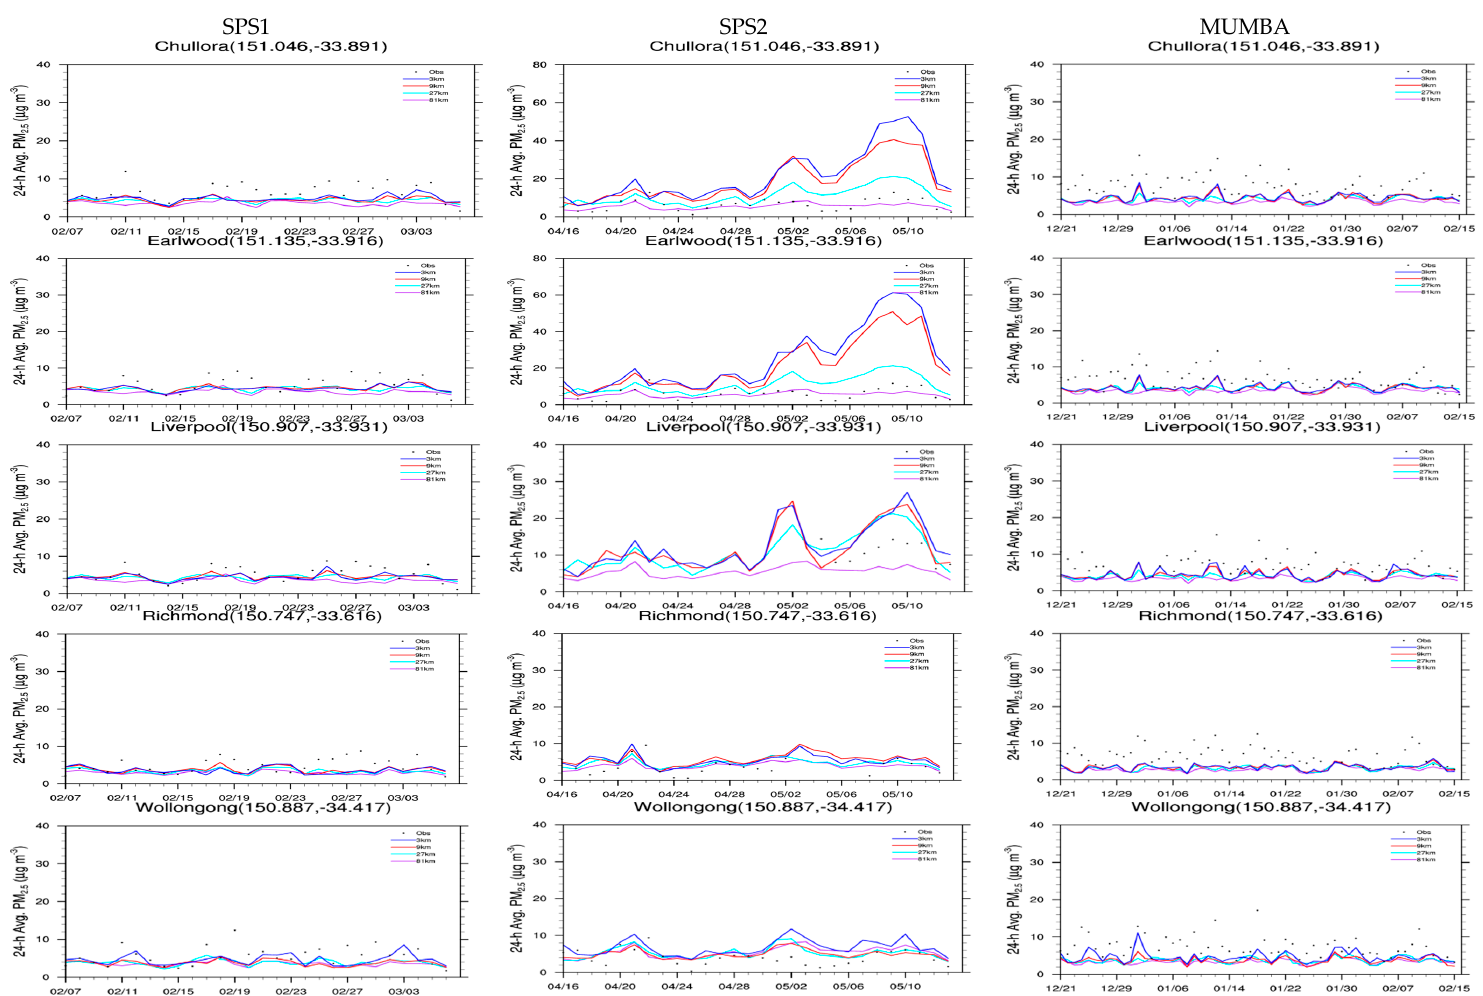
Figure 8. Observed and simulated temporal profiles of PM 2.5 concentrations at selected sites during SPS1, SPS2, and MUMBA. All simulation results are based on WRF/Chem-ROMS.